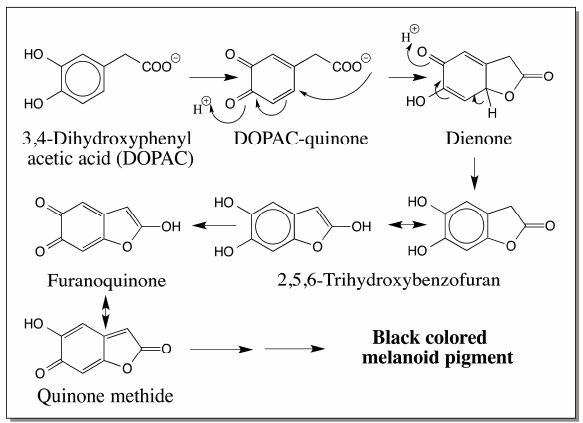
Figure 9. Oxidative cyclization of 3,4-dihydroxyphenylacetic acid. The quinone formed by the oxidation of 3,4-Dihydroxyphenylacetic acid among other reactions exhibits an intramolecular cyclization and produces a trihydroxybenzofuran, which undergoes oxidative polymerization yielding a black colored melanoid pigment.